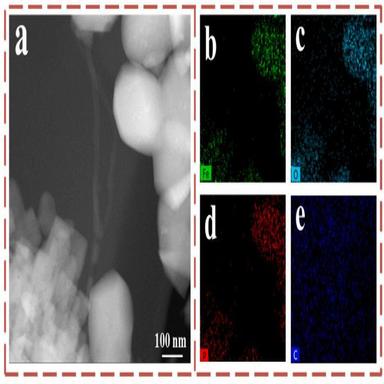
TEM image (a) and element mapping (b–e) of LiFePO4@MWCNTs.